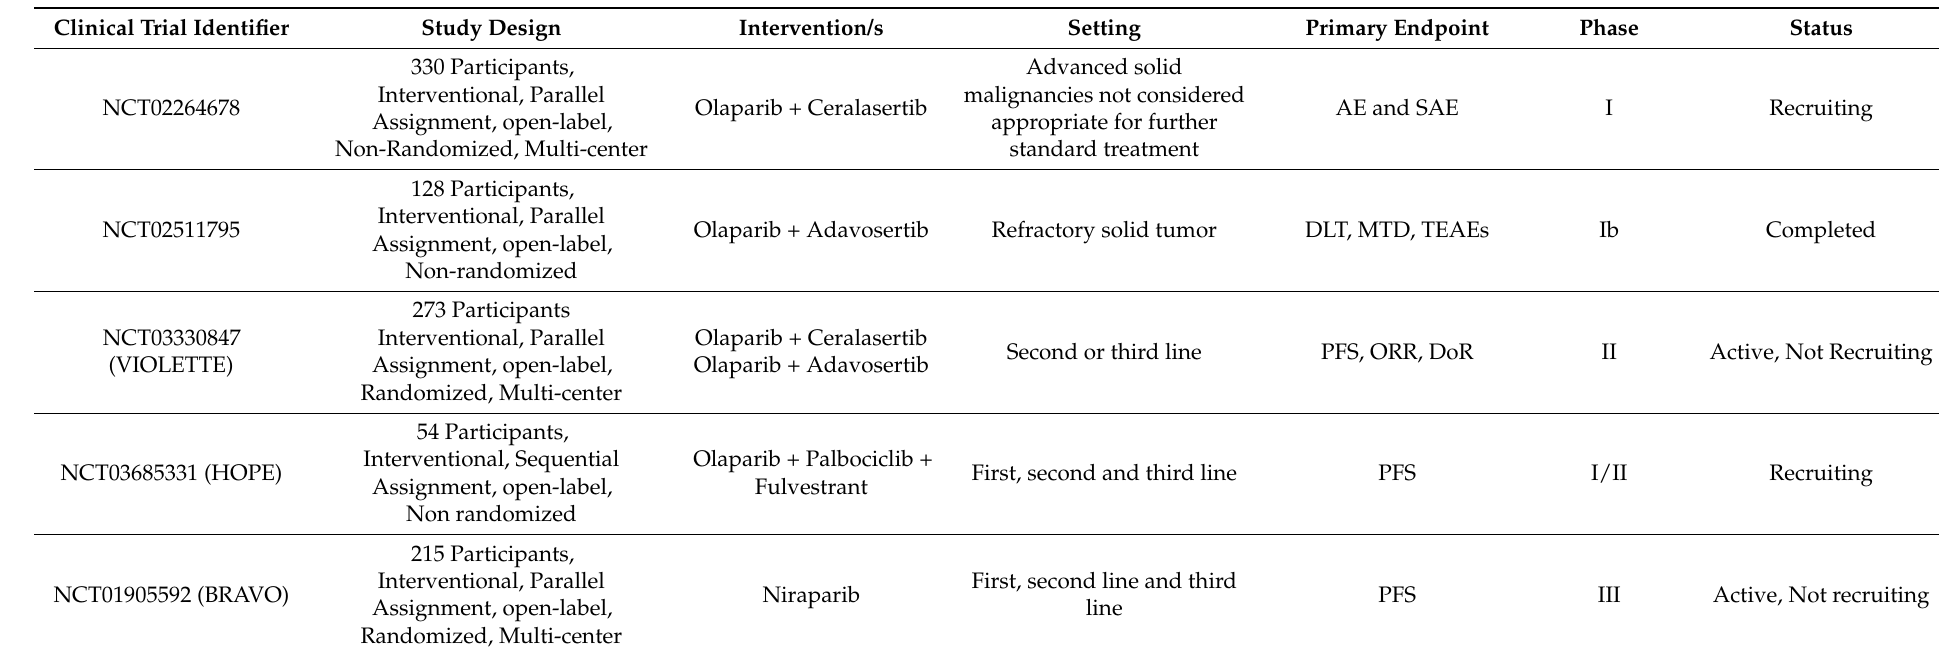
Table 3. Selected ongoing trials with PARP inhibitors in combinations with molecular targeted